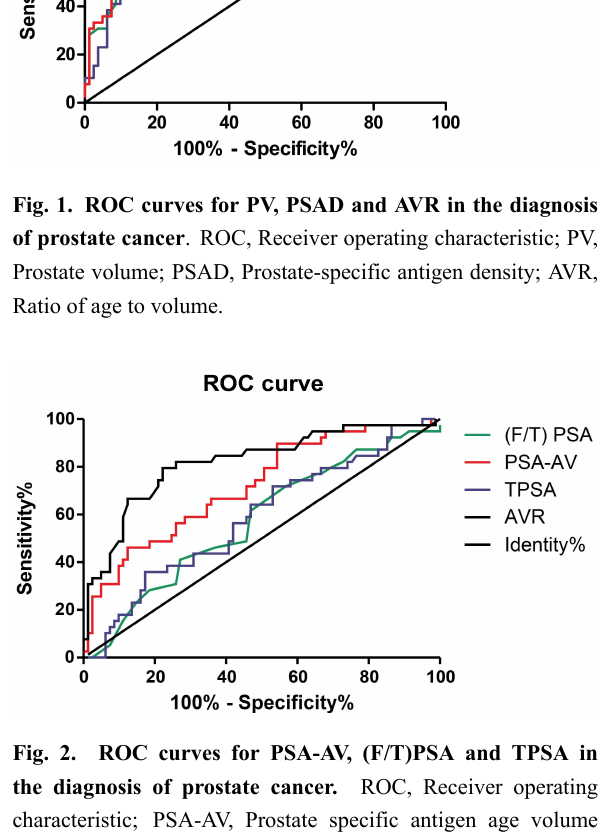
Fig. 2. ROC curves for PSA-AV, (F/T)PSA and TPSA in the diagnosis of prostate cancer. ROC, Receiver operating characteristic; PSA-AV, Prostate specific antigen age volume score; (F/T)PSA, Free/total prostate-specific antigen; TPSA, Total prostate-specific antigen; AVR, Ratio of age to volume. and PSA-AV were 99.87%, 14%, 99.96% and 63.11%,